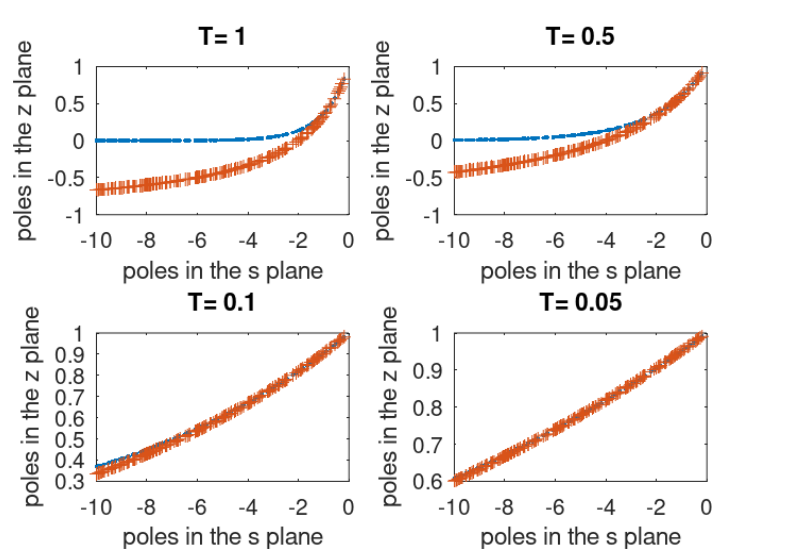
Figure 3. Comparison of pole transformations, for 4 values of T = 1 The horizontal axis represents the values of the pole, p , in the s plane. In the vertical axis, the corresponding values of θ and ζ originate the blue ( · ) and red ( + ) points,